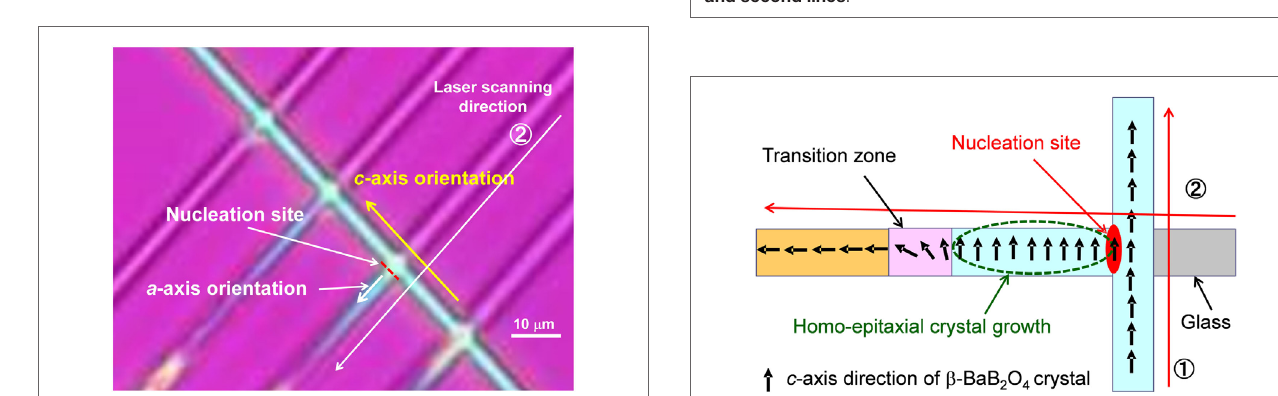
FigUre 8 | POM photograph focusing the crossing points of the first and second lines